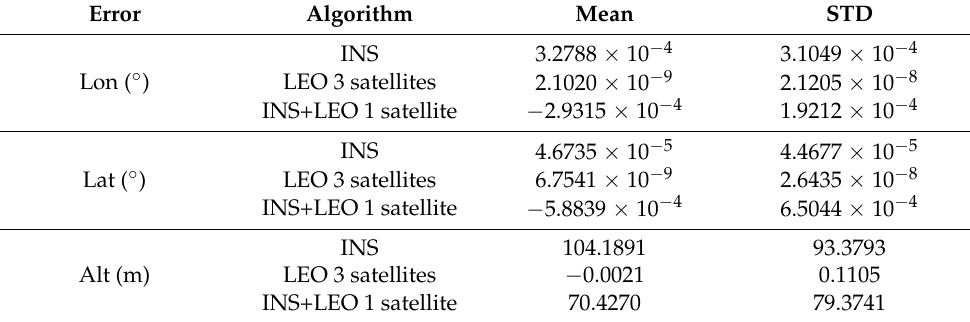
Table 4. Trajectory error